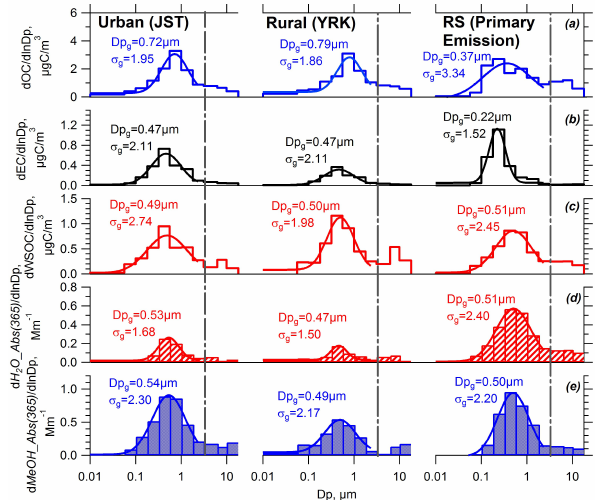
Fig. 3. Size distributions of (a) OC, (b) EC, (c) WSOC, (d) water- soluble absorption (365nm), and (e) methanol-soluble absorption (365nm) from MOUDI samples collected at JST, YRK and RS sites. The after filter is included as a size channel from 0.01 to 0.056µm. The vertical line at 3.1µm and all measurements below that size are viewed as fine particles. For JST and YRK the multiple measurements have been averaged. Geometric mean diameters and geometric standard deviations from lognormal fits to fine particles are included. Particle sizes are aerodynamic